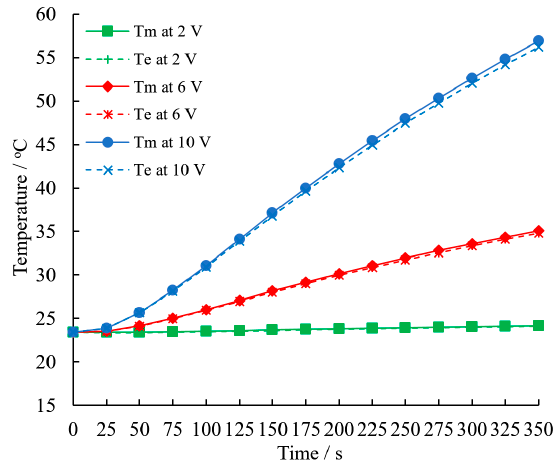
Figure 9. Temperature rising rate at the midpoint and end on the surface.